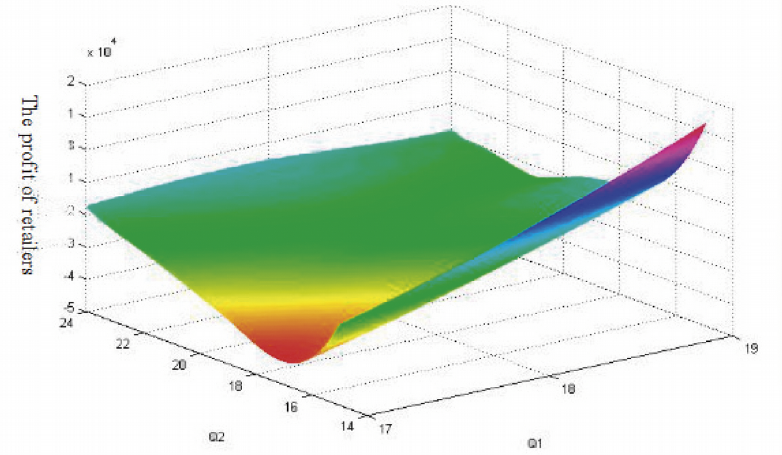
Figure 5. The curve of the retailer’s profit change with the change of Q1 and